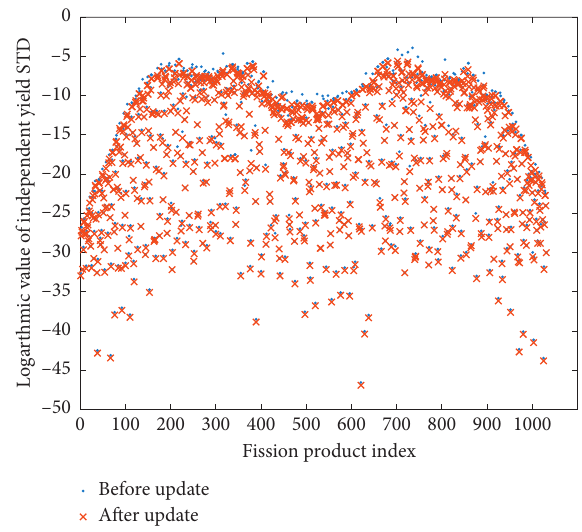
Figure 6: IFYs distribution before and after sequential Bayesian updating. Natural logarithm is presented on the y-scale. The fission product index refers to each fission product identified by its charge number Z , mass number A , and isomeric state I ( ZZAAAI ) . These indices are grouped by the mass number and arranged in a descending manner.